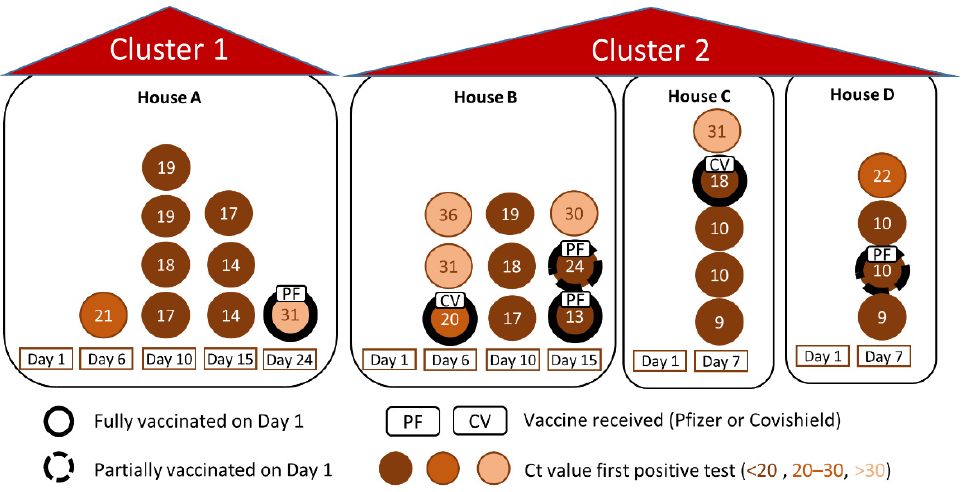
Figure 2. Epicurve showing positive cases per day and per house.